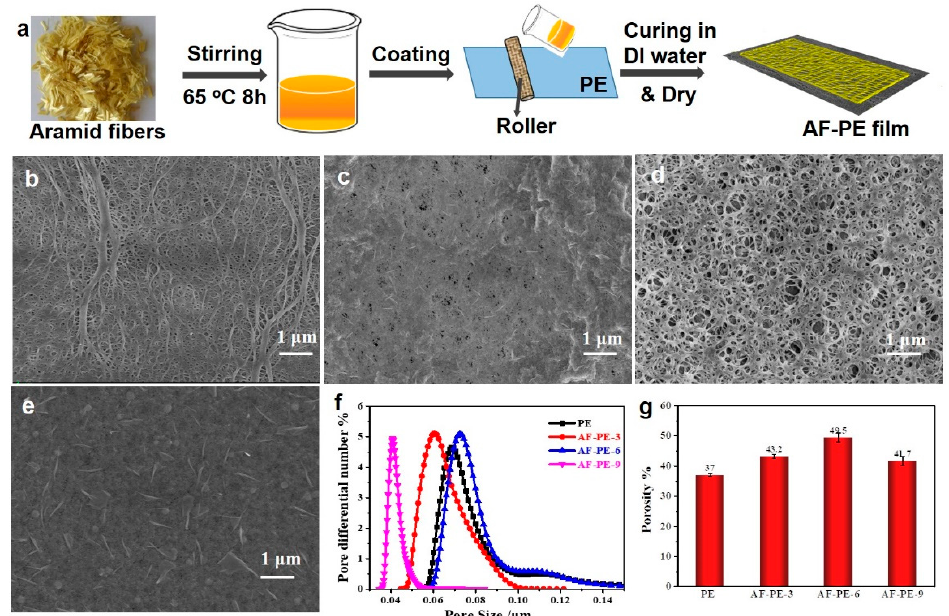
Figure 1. ( a ) Schematic illustration of the preparation of AF-PE films. SEM images of: ( b ) pristine PE film; ( c ) AF-PE-3; ( d ) AF-PE-6; and ( e ) AF-PE-9; ( f ) The pore size distribution of pristine PE, AF-PE-3, AF-PE-6 and AF-PE-9 films; ( g ) Porosity of PE and aramid-coated separator.